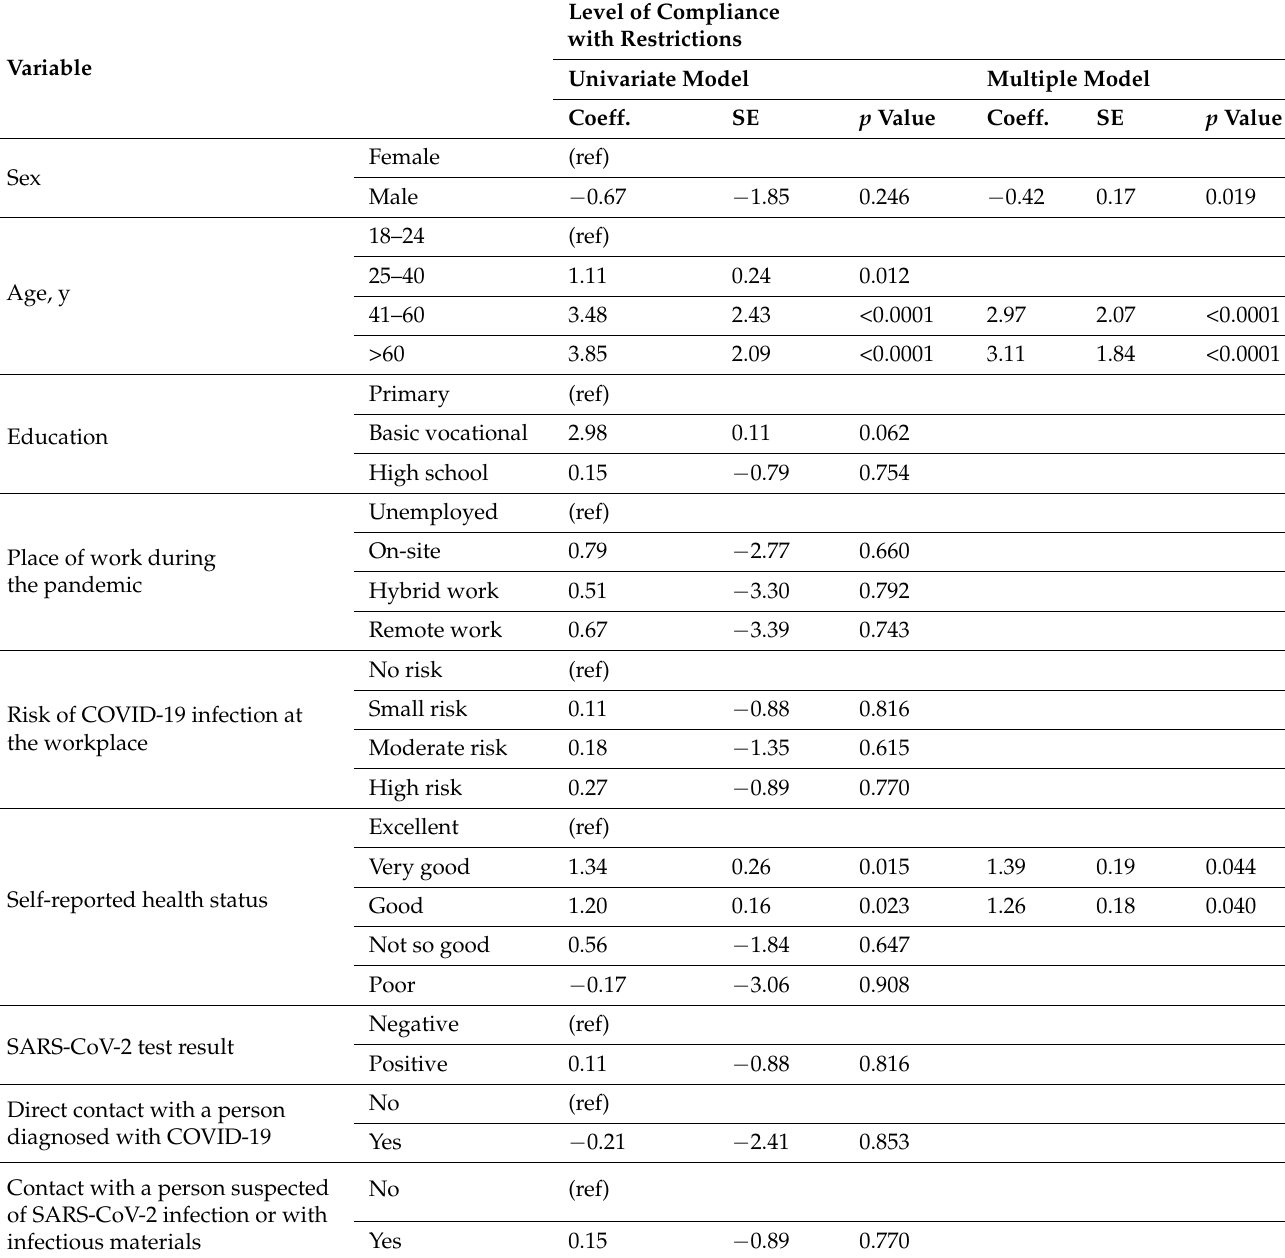
Table 4. Univariate and multiple regression analysis of selected factors related to compliance with pandemic restrictions among